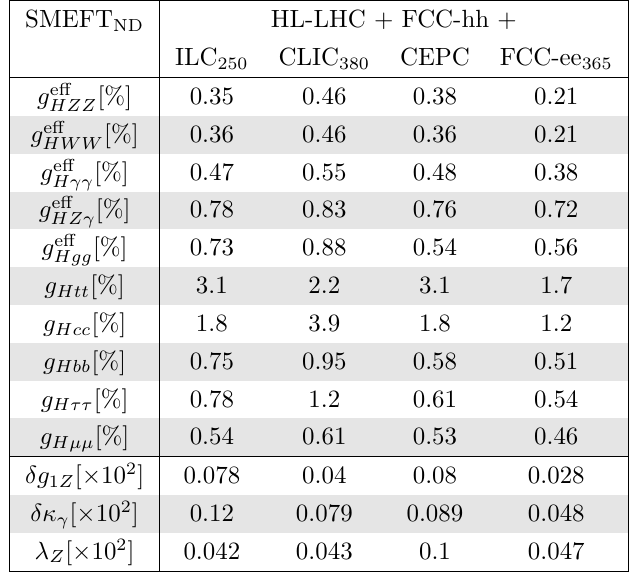
Table 32 . Results for the global EFT (cid:12)t for FCC-hh combined with any of the four e + e proposed, also shown in table 31.